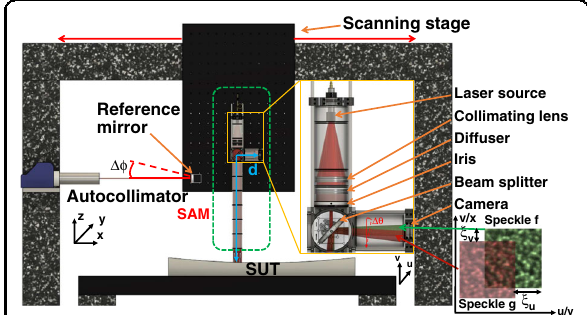
Fig. 1 Schematic representation of the experimental setup for speckle angular measurement (SAM). The SAM instrument is attached to the air-bearing scan stage, and the speckle pattern from the re fl ected mirror surface shifts when the speckle is projected onto different parts of the surface under test (SUT). The angle change can be calculated from the speckle displacement between two speckle subset images (f and g) by employing the sub-pixel tracking algorithm. The carriage slide ’ s pitch error is measured with an autocollimator, and the change of the SUT ’ s slope is derived from the SAM and the autocollimator (AC)